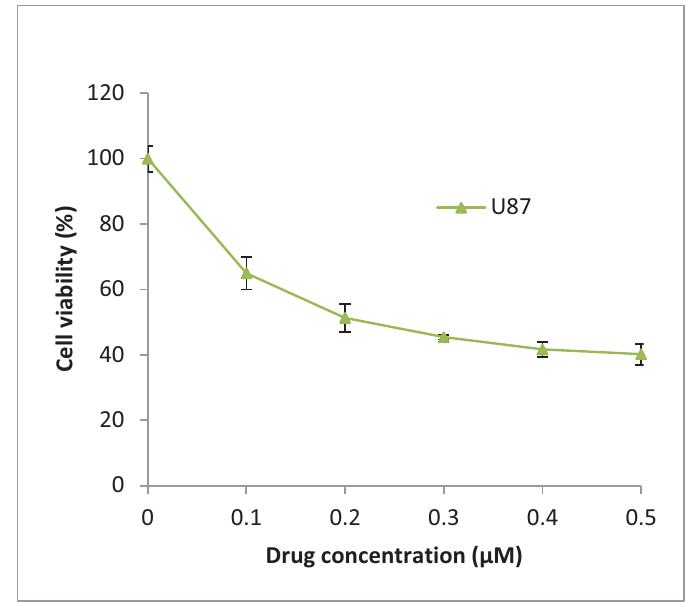
Figure 6 . The IC for the Hsp90 inhibitor 17-AAG was assessed by increasing concentration 50 of 17-AAG (0 – 0.5 µM). The data values are mean ± SD, n =